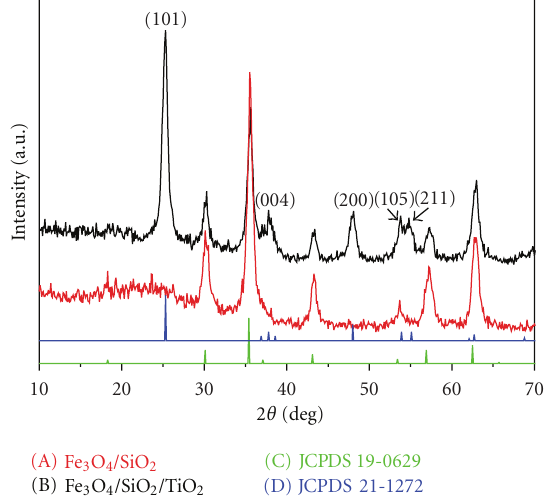
Figure 1: XRD pattern of Fe 3 O 4 /SiO 2 (A) and Fe 3 O 4 /SiO 2 /TiO 2 composites (B). The Fe 3 O 4 /SiO 2 and Fe 3 O 4 /SiO 2 /TiO 2 composites were characterized by XRD. As shown in Figure 1(A), all peaks can be indexed as the magnetite phase of Fe 3 O 4 (JCPDS 19-0629).